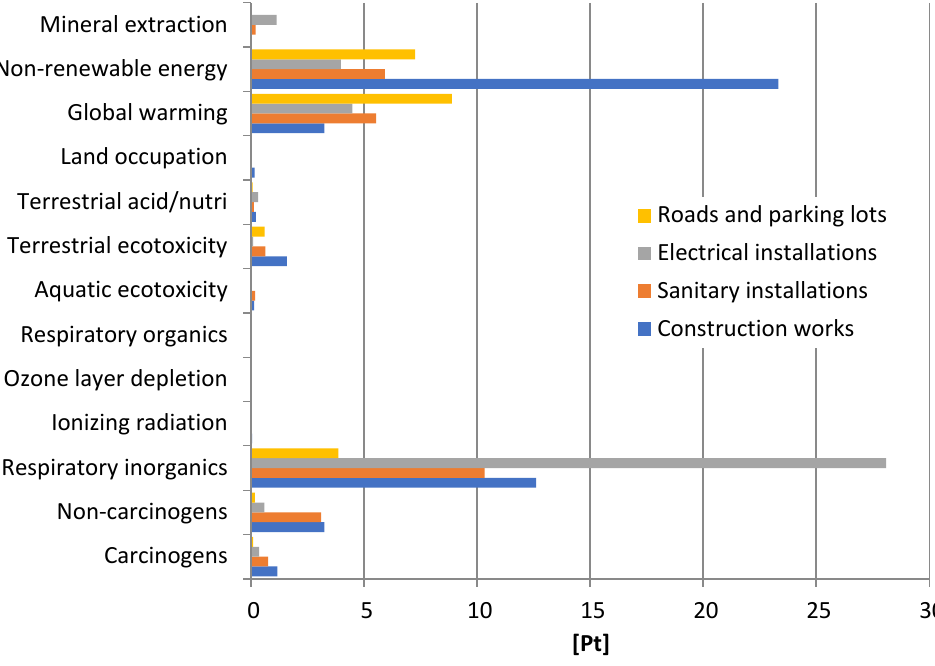
Figure 11. The results of grouping and weighing the environmental consequences occurring at the stage of production of the research object by thirteen impact categories and groups of installations.